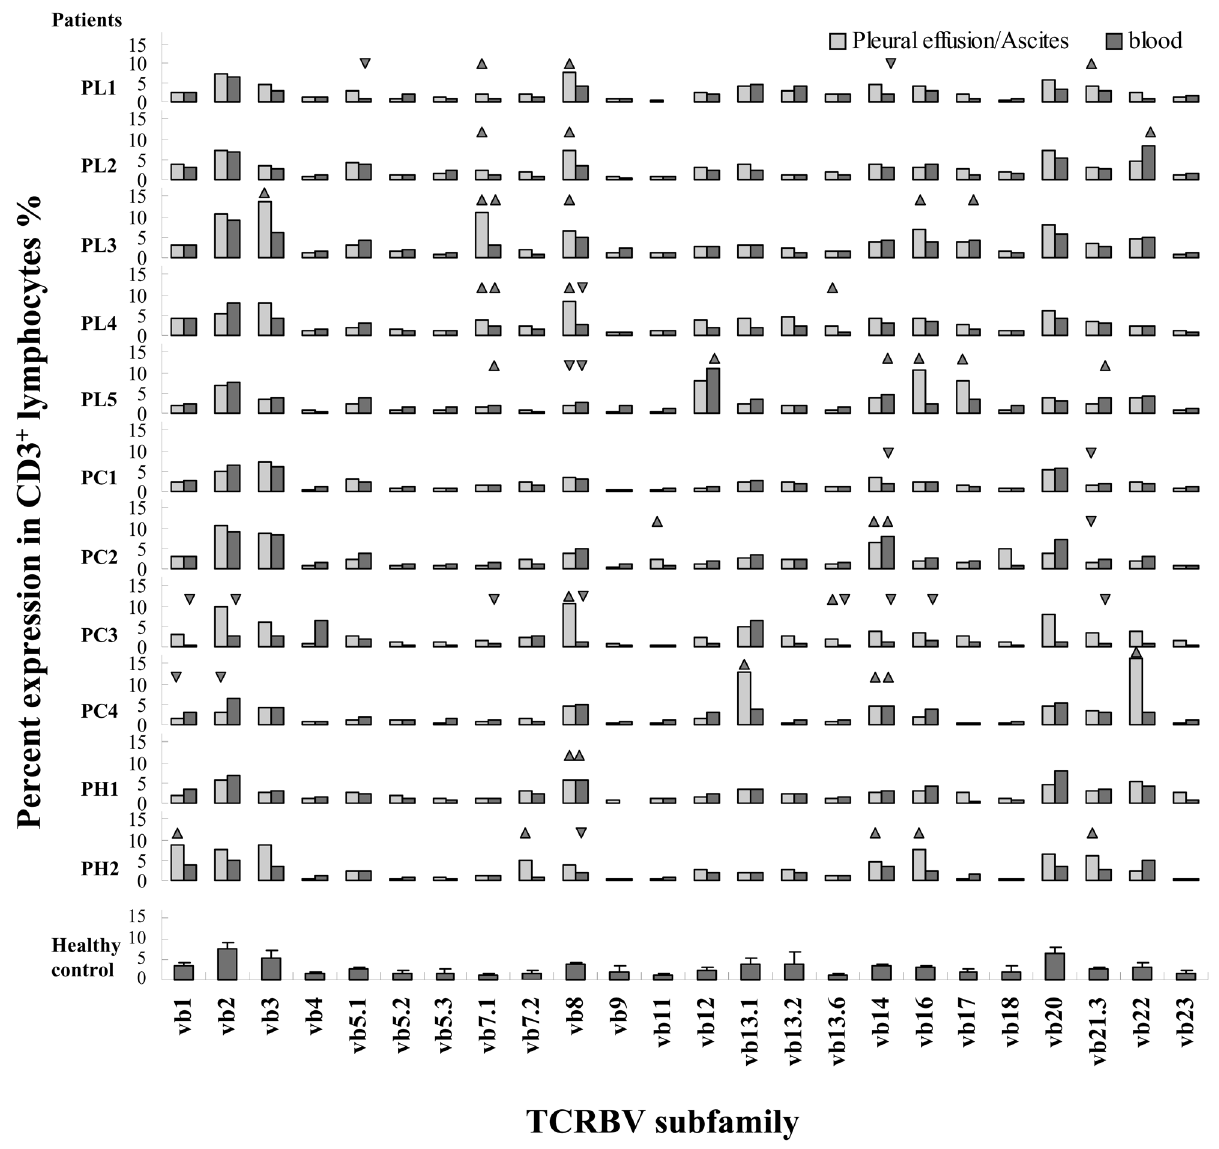
Figure 1. TCR repertoire in TIL and PBL of cancer patients. The TIL or peripheral blood lymphocytes were stained with anti-CD3 and 24 anti- TCRBV antibodies from a TCR V b Repertoire Kit. After lysing erythrocytes, washing, and fixing, TIL or PBL were subjected to FCM analysis. For a given TCRBV subfamily expression, any value higher or lower than the mean of the healthy control group, plus or minus 3 SD, was considered abnormal expression (higher labeled with triangle m ; lower labeled with inverted-triangle . ). PL indicates patient with lung cancer, PC indicates patient with colon cancer, PH indicates patient with liver cancer.